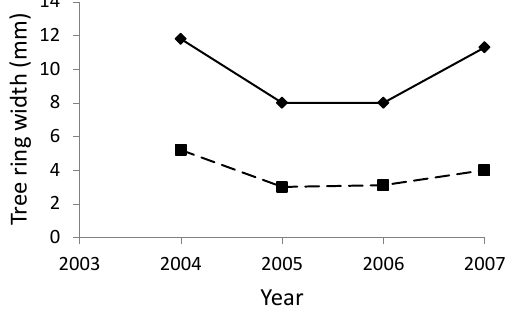
Figure 5. Change in tree ring width of cottonwood (solid line, di- amonds) and willow (dashed line, squares) before (2004), during (2005–2006) and after draining the reservoir (early 2005) and refill- ing (mid 2006). Redrawn from Hultine et al.